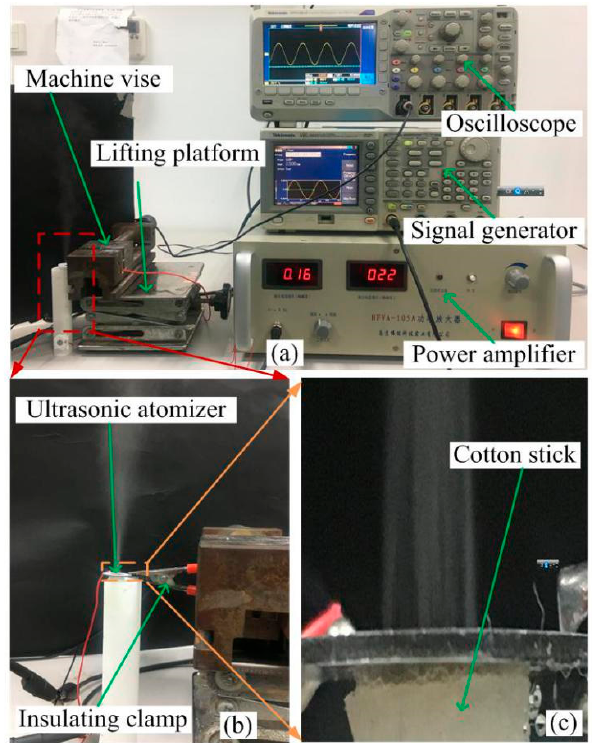
Figure 7. Photograph of the atomization rate measurement apparatus. ( a ) Photograph of the atomization rate measurement apparatus; ( b ) A partial enlarged view of figure ( a ); ( c ) A partial enlarged view of figure ( b ).